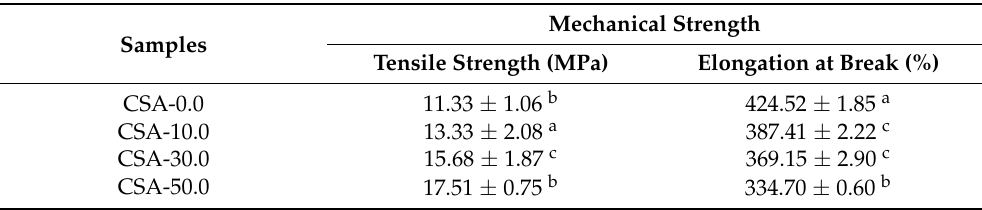
Figure 4. ( a ) Stress versus strain curves; ( b ) Tensile strength and elongation at break of CSA composites. Table 1. Mechanical strength of chitosan and CSA